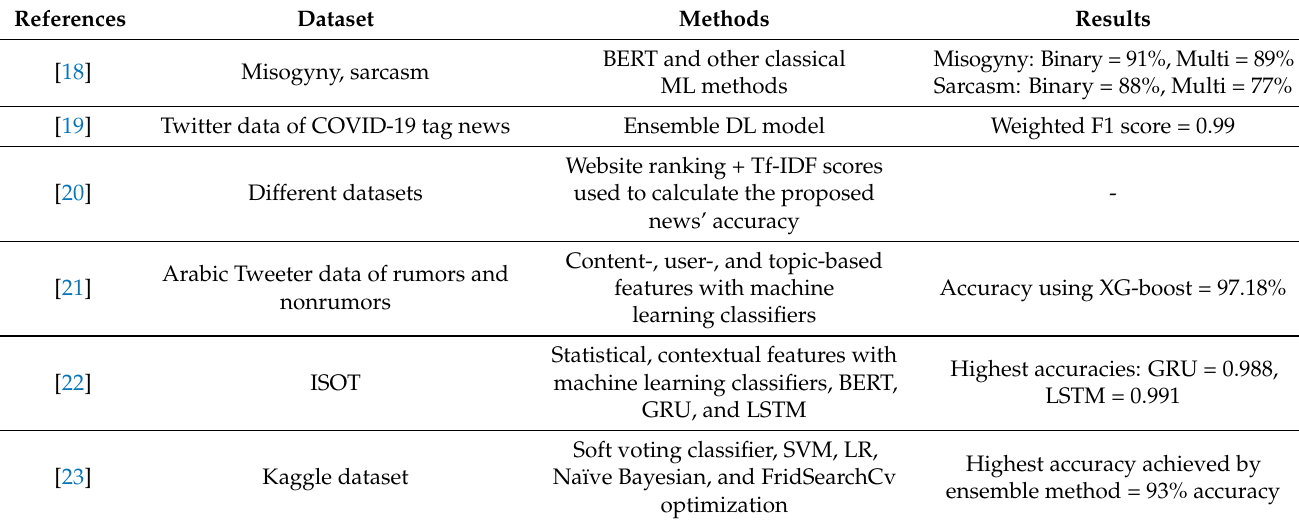
Table 2. Summary of fake news detection methods applied in